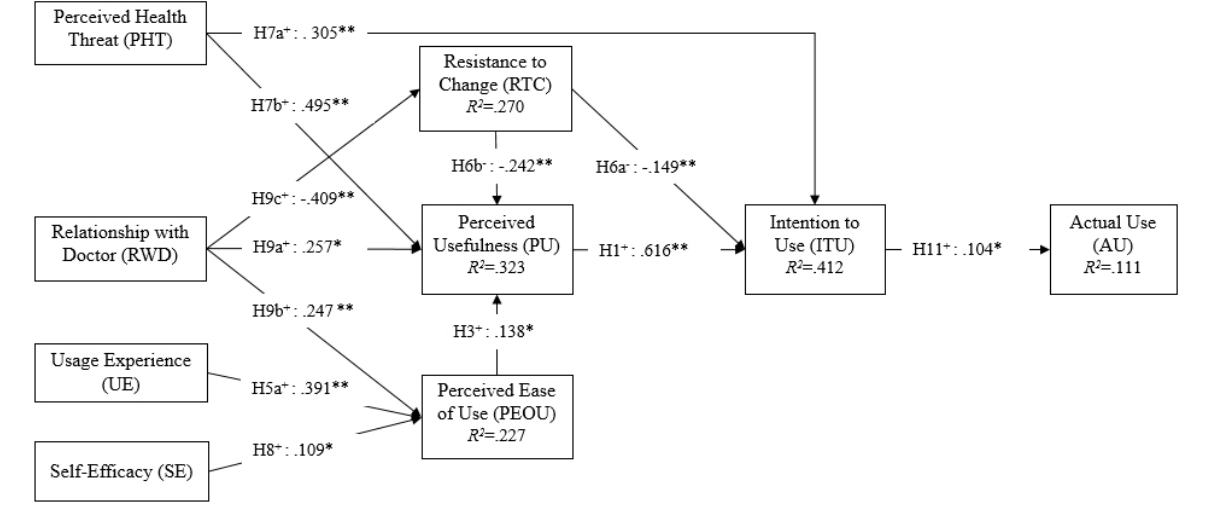
Figure 4. The validated theoretical model. * P <.05, ** P